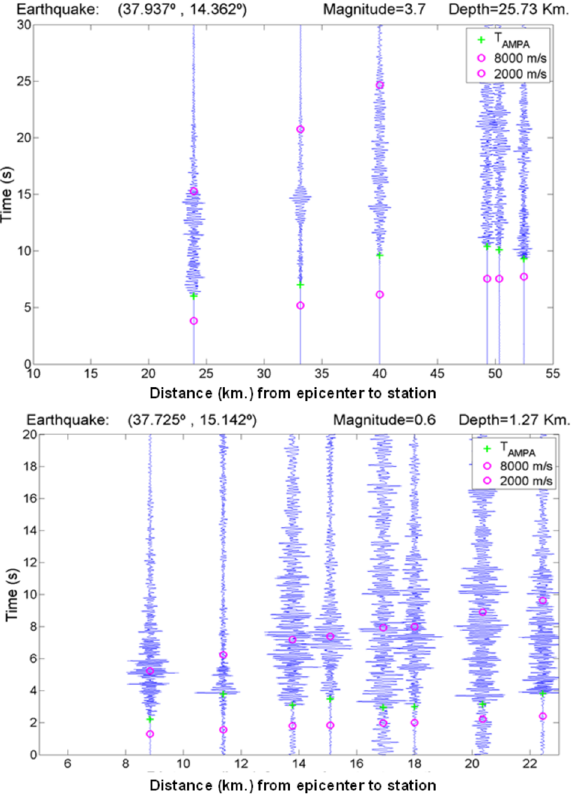
Figure 14. Detailed zoom of the picking of a few events from Fig- ures 12 and